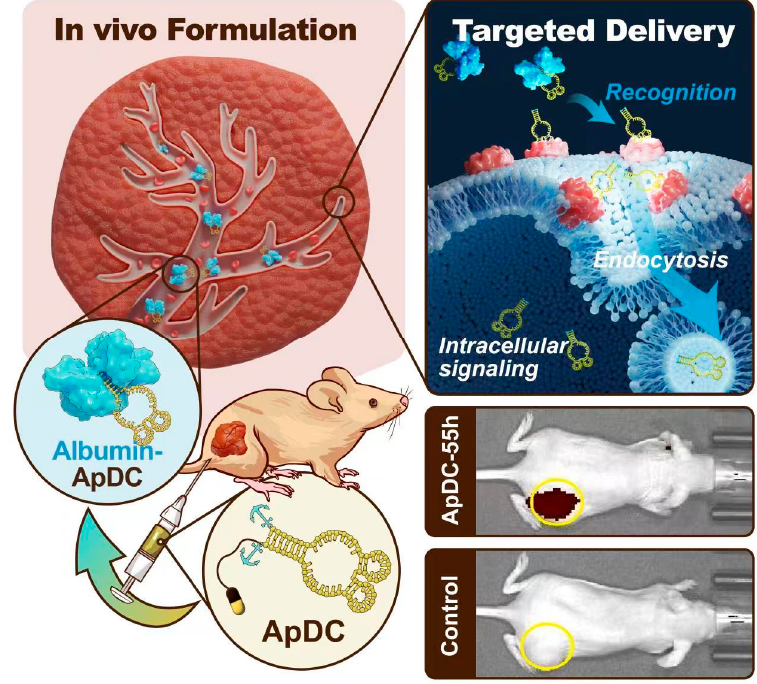
Scheme 1. Schematic illustration of the targeted delivery system of artificial base-modified ApDC. After intravenous injection of ApDC, terminal F bases as anchors would direct the formulation of the albumin-ApDC complex within the blood circulation; ApDC could be sheltered from fast enzymatic degradation and renal excretion, and accumulate in the tumor